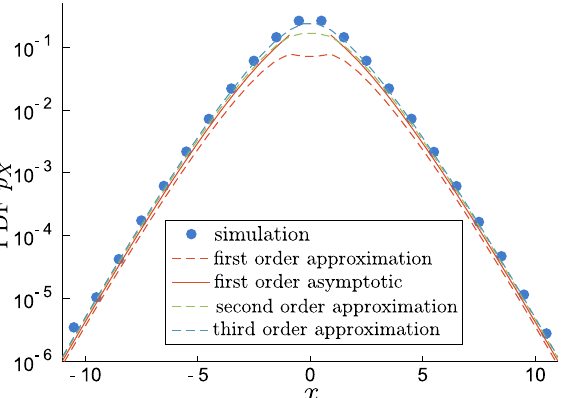
Figure 11. Comparison of the simulated compound Poisson process, expansion (35) and asymptotical 2 . For smaller times t (cid:31) 1 the fit is even better. For larger t , as Gaussian regime starts the formula (36) for t = exponential behaviour is pushed towards larger | x